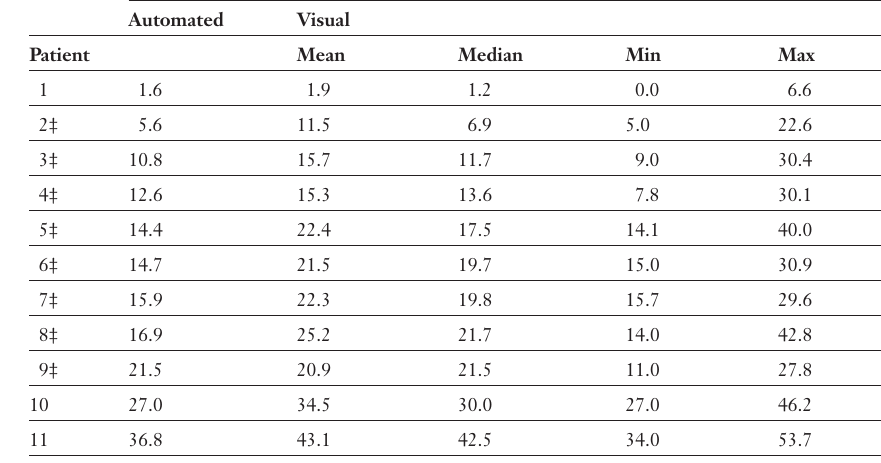
iCC measuring agree- ment between observers for apnoea hypopnoea index, hypopnoea index, apnoea index and O 2 desaturation